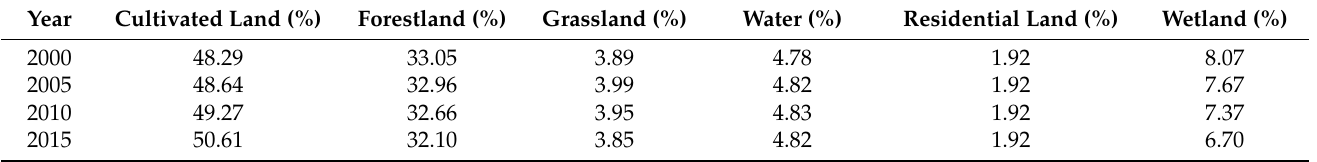
Table 2. Temporal variation of land use